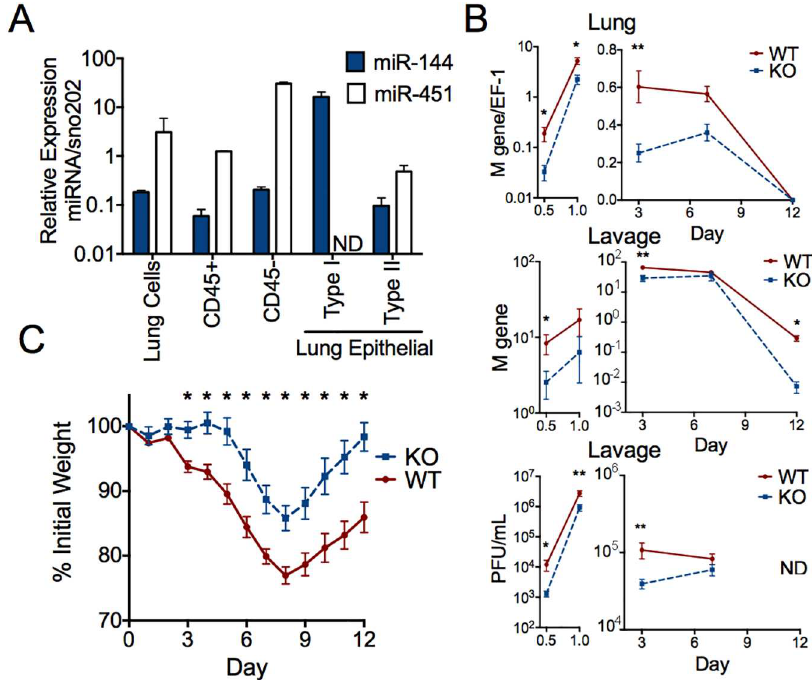
Fig 1. miR-144and miR-451are expressedin lung epithelial cells. ( A ) Expression of miR-144and miR- 451 in total lung cells and FACS-purified lung hematopoietic and epithelialcell populations were measured by qRT-PCR and plotted in arbitrary units relative to sno-202expression. Means ± SEM for 3–8 samples are shown. ( B ) miR-144/451 null or wild-typelittermate mice were infected with influenzavirus for 0.5, 1, 3, 7, or 12 d. Influenzavirus was quantifiedby qRT-PCR of viral M gene in lungs (normalized to EF-1) or BAL, or by plaqueassay of BAL. Means ± SEM are shown; 0.5 d ( n = 8–9), 1 d ( n = 3–6), 3 d ( n = 4–11), 7 d ( n = 5), 12 d ( n = 3–6). PFUs were belowthe detectionlimit at 12 d (ND, not detected). Similar data was obtainedin two independent experiments. ( C ) Weight-loss was quantified over 12 d as a correlate of morbidity( n = 10–19 mice per time point); reducedweight-loss in KO mice was observed in 5 independent experiments; * p < 0.003.